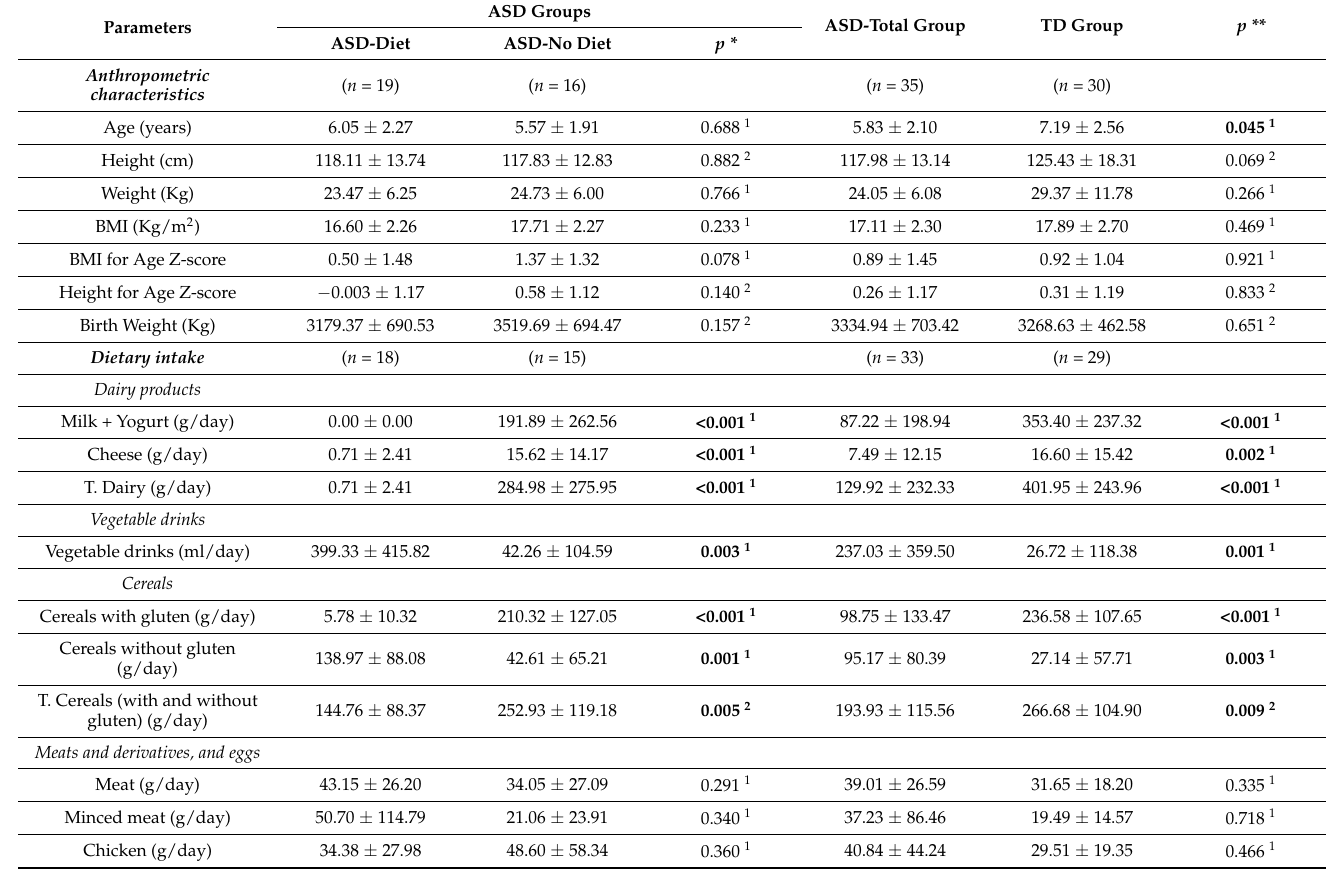
Table 1. Anthropometric characteristics and dietary intake in children with autism spectrum disorder and typical